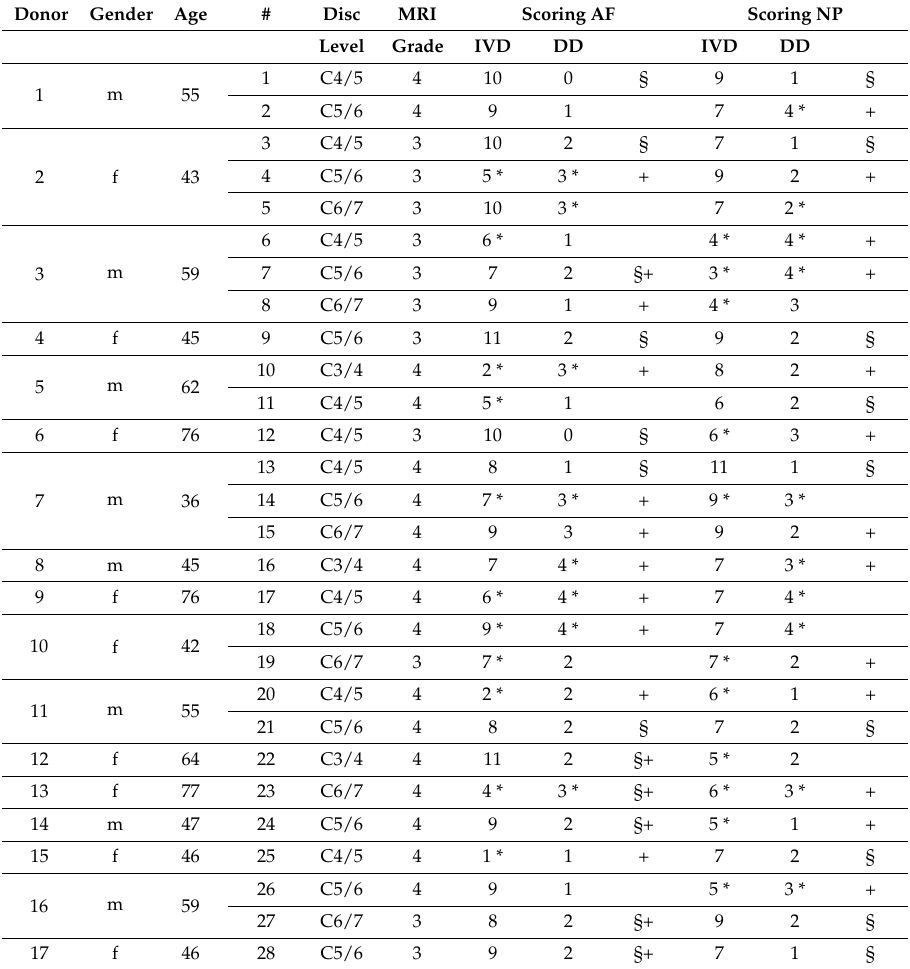
Table 2. Disc degeneration (DD) score to assess the degenerative grade of small-sized disc samples on cellular level. normal and white coloured 0 macroscopic/haptic slightly harder or yellowish 1 sclerotic or greyish 2 normal, no cell clusters 0 cellularity (alcian blue staining) mixed cellularity, some cell clusters or enlarged cells 1 mainly clustered cells, chondroid nests present 2 no sign of calcification 0 calcification (von Kossa staining) small spots of black staining or extensive greyish staining 1 intense black staining 2 maximum DD score 6